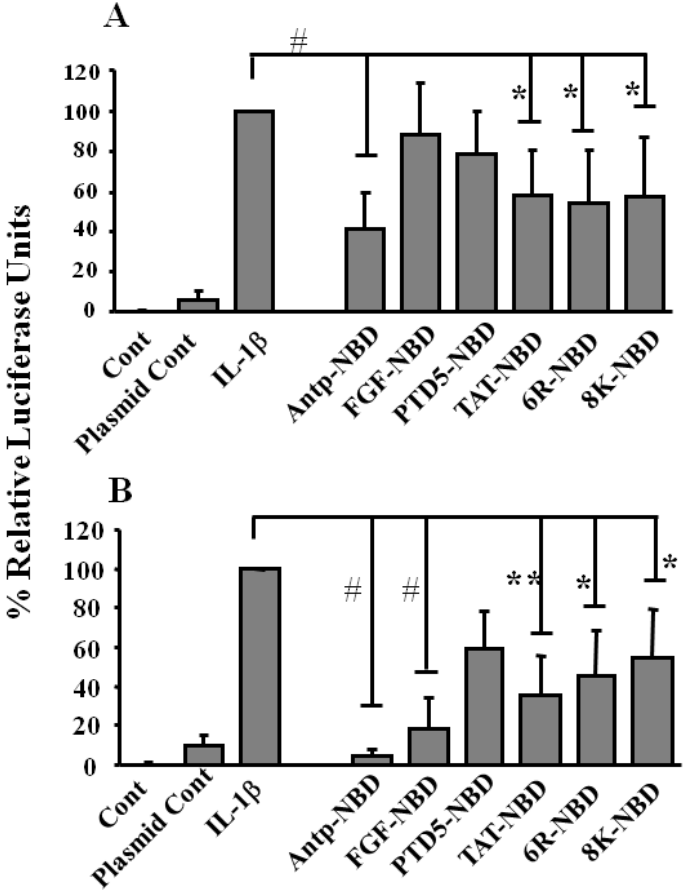
Figure 3. Inhibition of NF- κ B activation by PTD-NBD peptides. Inhibition of the IL-1ß induced activation of the NF- κ B by 10 μ M (Panel A) and 100 µM (Panel B) PTD-NBD peptides. HeLa cells were transfected pNF- κ B-Luc and pTK-Renilla. Cells were pretreated with 10 or 100 µM of the indicated PTD-NBD for 1 and exposed to IL-1ß for additional 3 h. The results are expressed as relative luciferase activity of three different experiments carried out in triplicate (mean ± s.d.). # P < 0.001; ** P <0.01; * P